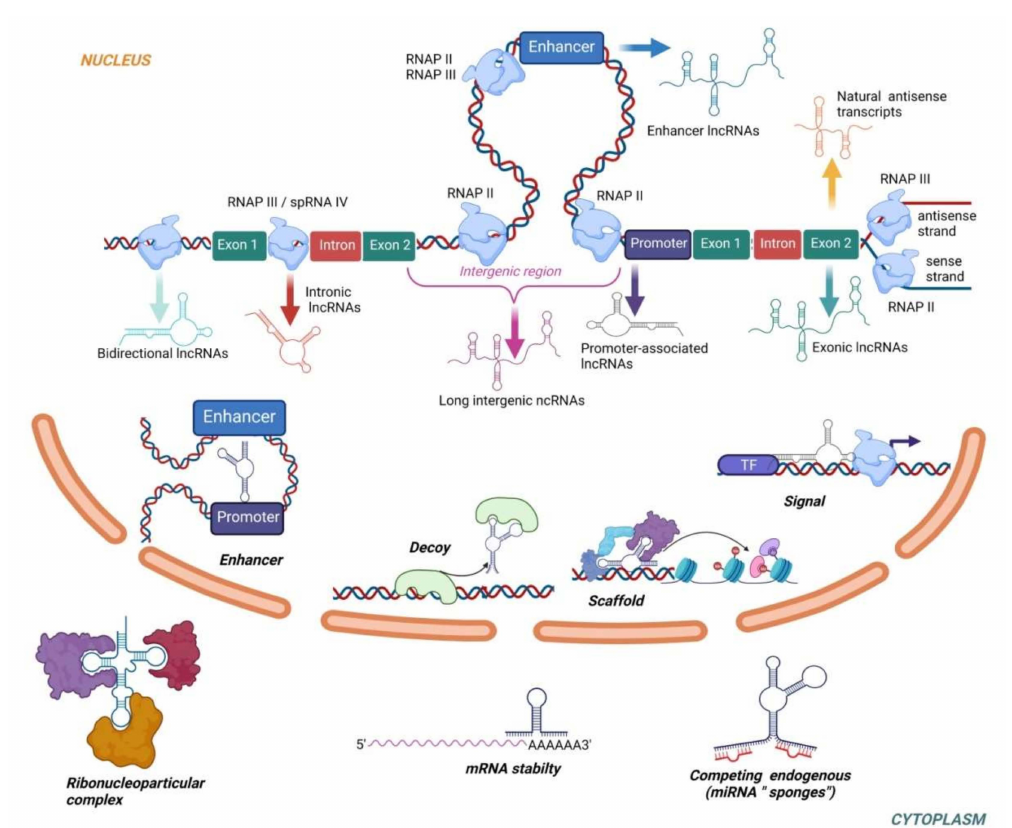
Figure 2. The biogenesis and functions of lncRNAs. Based on the transcriptional origin, lncRNAs are classified as exonic, intronic, antisense, enhancer, intergenic, promoter-associated and bidirectional. The vast majority of lncRNAs is transcribed by RNAP II. RNAP III catalyzes transcription of natural antisense transcripts from the antisense strand of exons, enhancer lncRNAs without poly-A tale and intronic lncRNAs in combination with spRNAP IV. In the nucleus, lncRNAs regulate gene expression by acting as transcriptional signals, scaffolds, decoys or enhancers. In the cytoplasm, lncRNAs can increase/decrease mRNA stability, act as miRNAs “sponges” or interact with proteins to form ribonucleoprotein